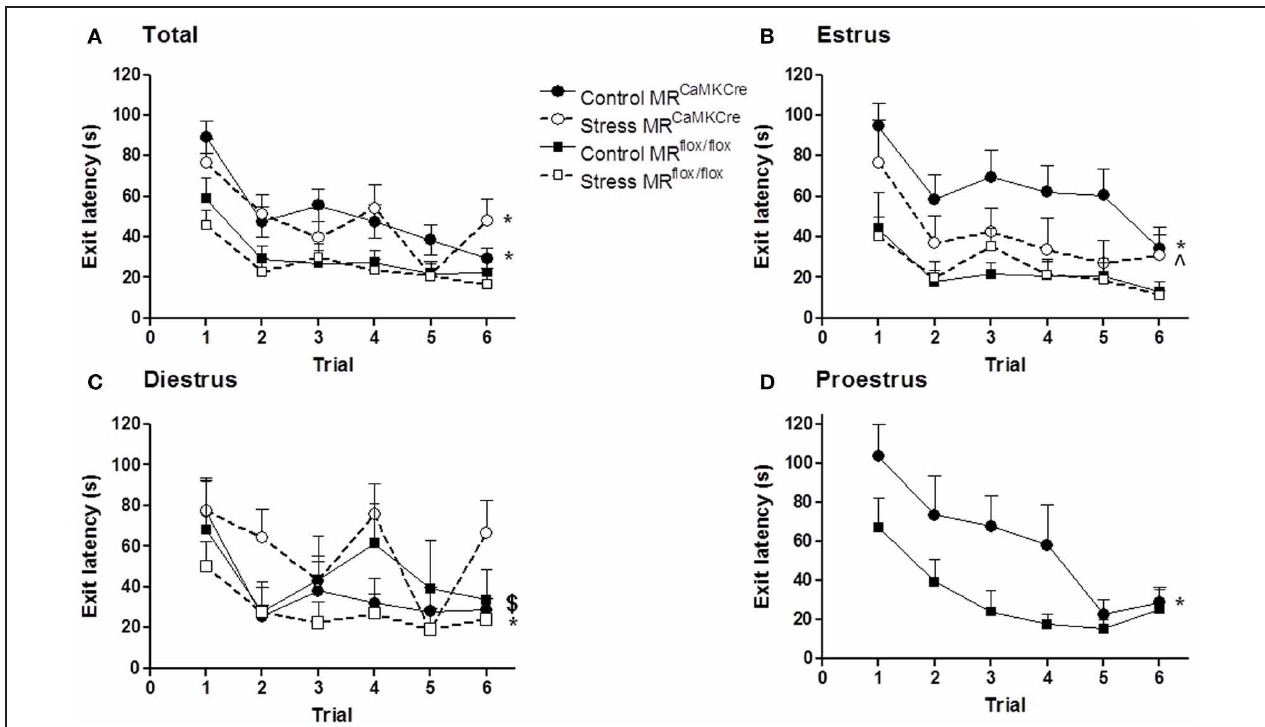
however, it improves the performance of estrus MR CaMKCre mice ( n = 6). Black circles with the solid line are control MR CaMKCre mice and black squares with a solid line represent control MR flox / flox mice. White circles with a dotted line are stressed MR CaMKCre mice and white squares with the dotted line represent stressed MR flox / flox mice. ∗ p < 0 . 05, compared to MR CaMKCre same estrous cycle phase; $ p < 0 . 05, compared to estrus within MR CaMKCre mice; ∧ p < 0 . 05, compared to control estrus MR CaMKCre